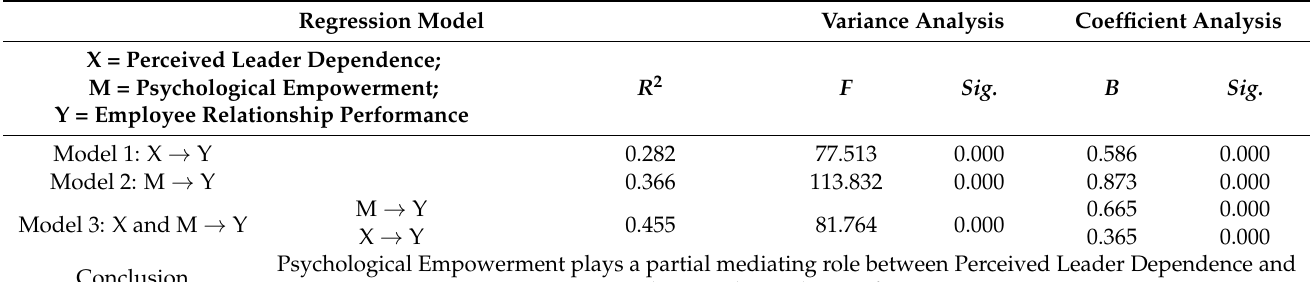
Table 23. Test of the Mediating Effect of Psychological Empowerment between Perceived Leader Dependence and Employee Relationship Performance. Regression Model Variance Analysis Coefficient